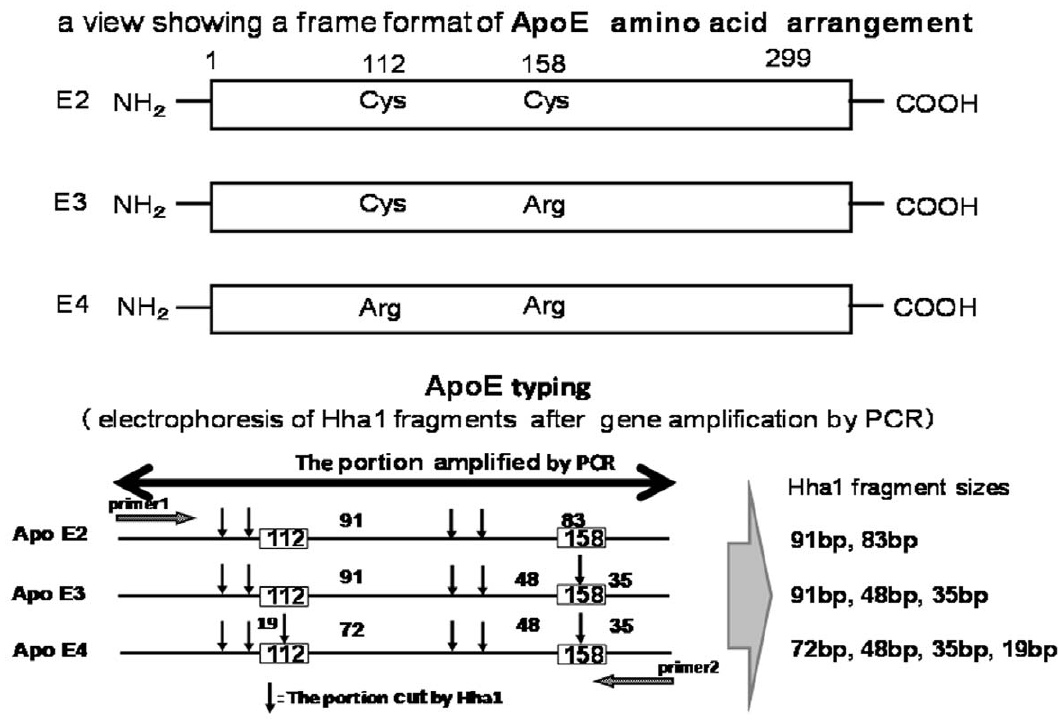
Figure 1. ApoE isoform and Hha1cleavage maps. Each genotype of apoE was distinguished by unique combinations of Hha1 fragments. Cys:Cysteine, Arg:Arginine.